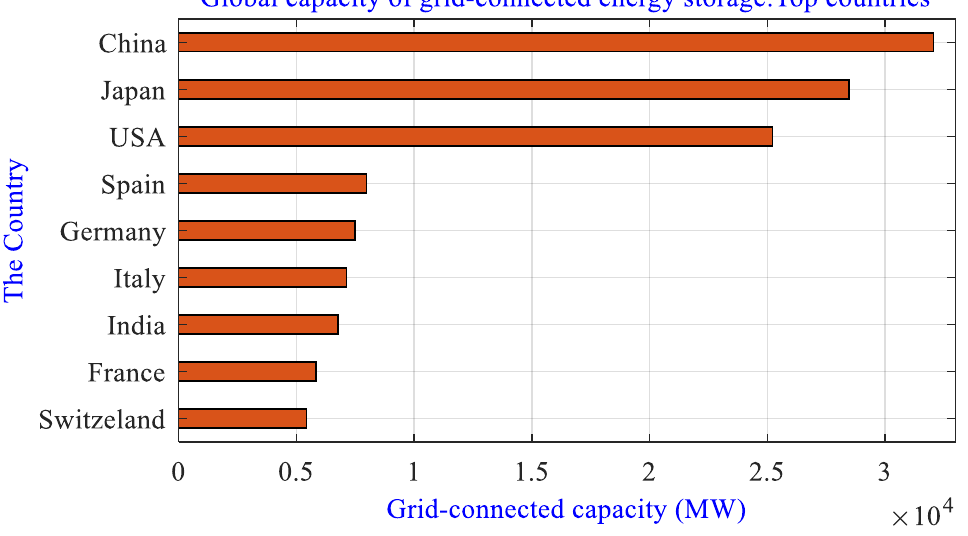
Figure 6. The capacity of grid-connected energy storage for top countries all around the world. Based on the IEA’s latest report, as of the end of 2020, the total installed battery storage capacity was roughly 17 GW. In 2020, compared to a disappointing 2019, installations increased by 50%. In the same year, 5 GW of storage capacity was added globally, with China and the United States leading the way with gigawatt-scale installations. Grid- connected-scale installations remain dominant in the industry and account for about two-thirds of the total capacity that has been added [46]. Figure 7 shows the yearly energy storage additions per country from 2015 to 2020. By 2026, installed storage capacity around the globe is expected to increase by 56% to over 270 GW [47]. The primary factor driving this market is the need to fully use and integrate bigger shares of various renewable energy sources (RESs) into power systems. As a result, there is a growing need worldwide for more system flexibility and storage capacity that HESSs can